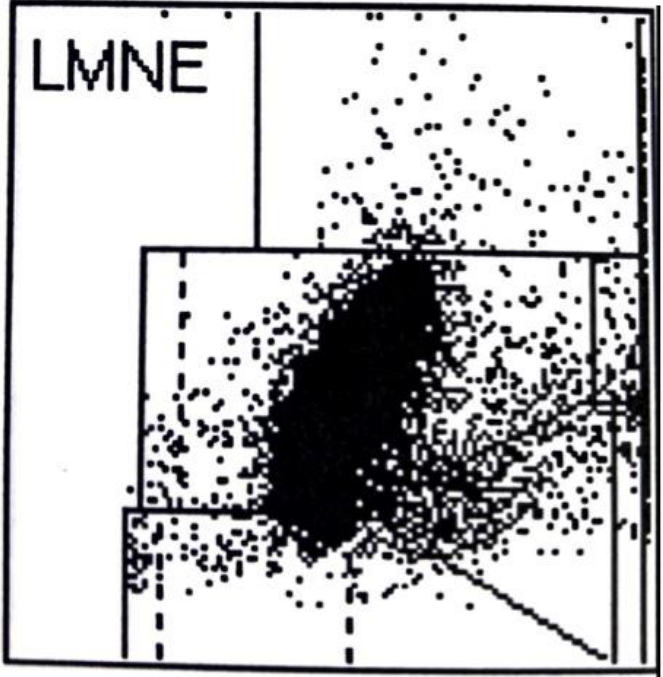
Figure 2. LMNE matrix of a type II (infection type) with a cluster, or increase, in the area of the neutrophils of a 68 year old male patient 5 weeks after implantation of a knee arthroplasty. The measured cell count was 21,900 cells/µL with 89.7% PMN and a CRP of 27.1 mg/L.